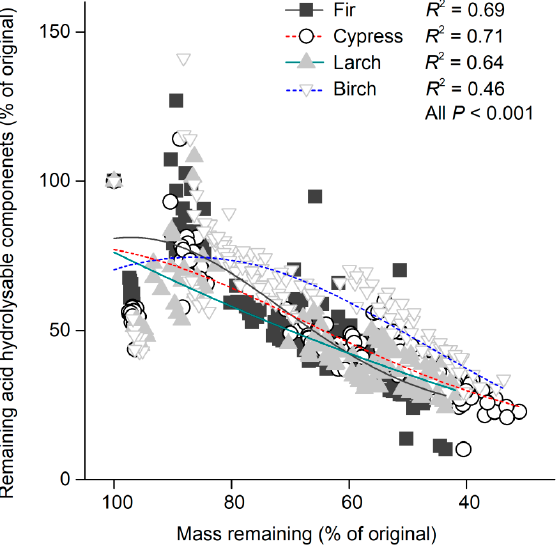
Figure 7. Remaining litter mass versus acid hydrolysable components for each litter species. Adjusted R 2 values from Gaussian functions are shown for each litter species, and all p < 0.001 ( n = 144 for each litter species).